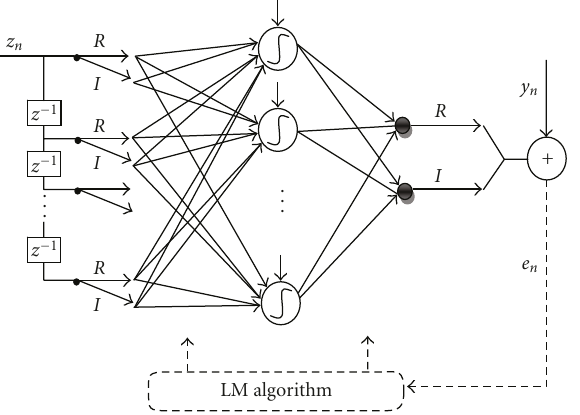
Figure 20: Fully connected NN predistorter structure.